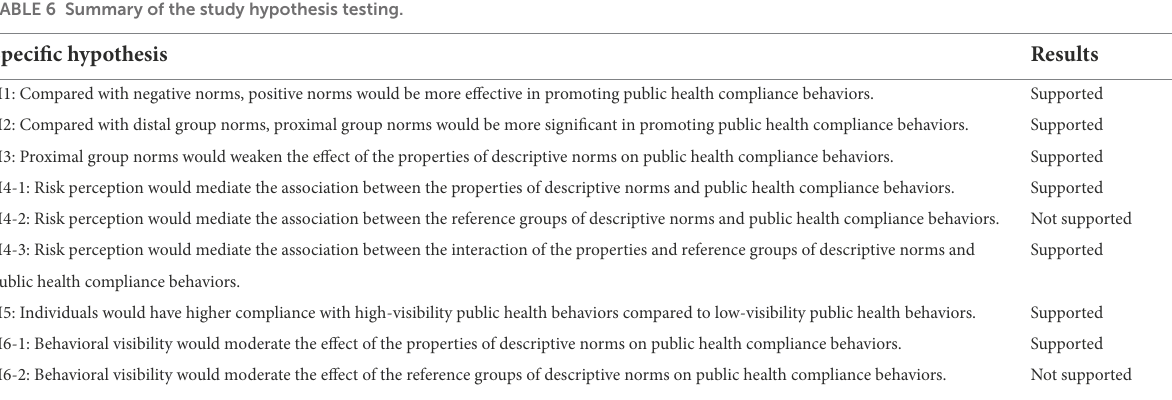
TABLE 6 Summary of the study hypothesis